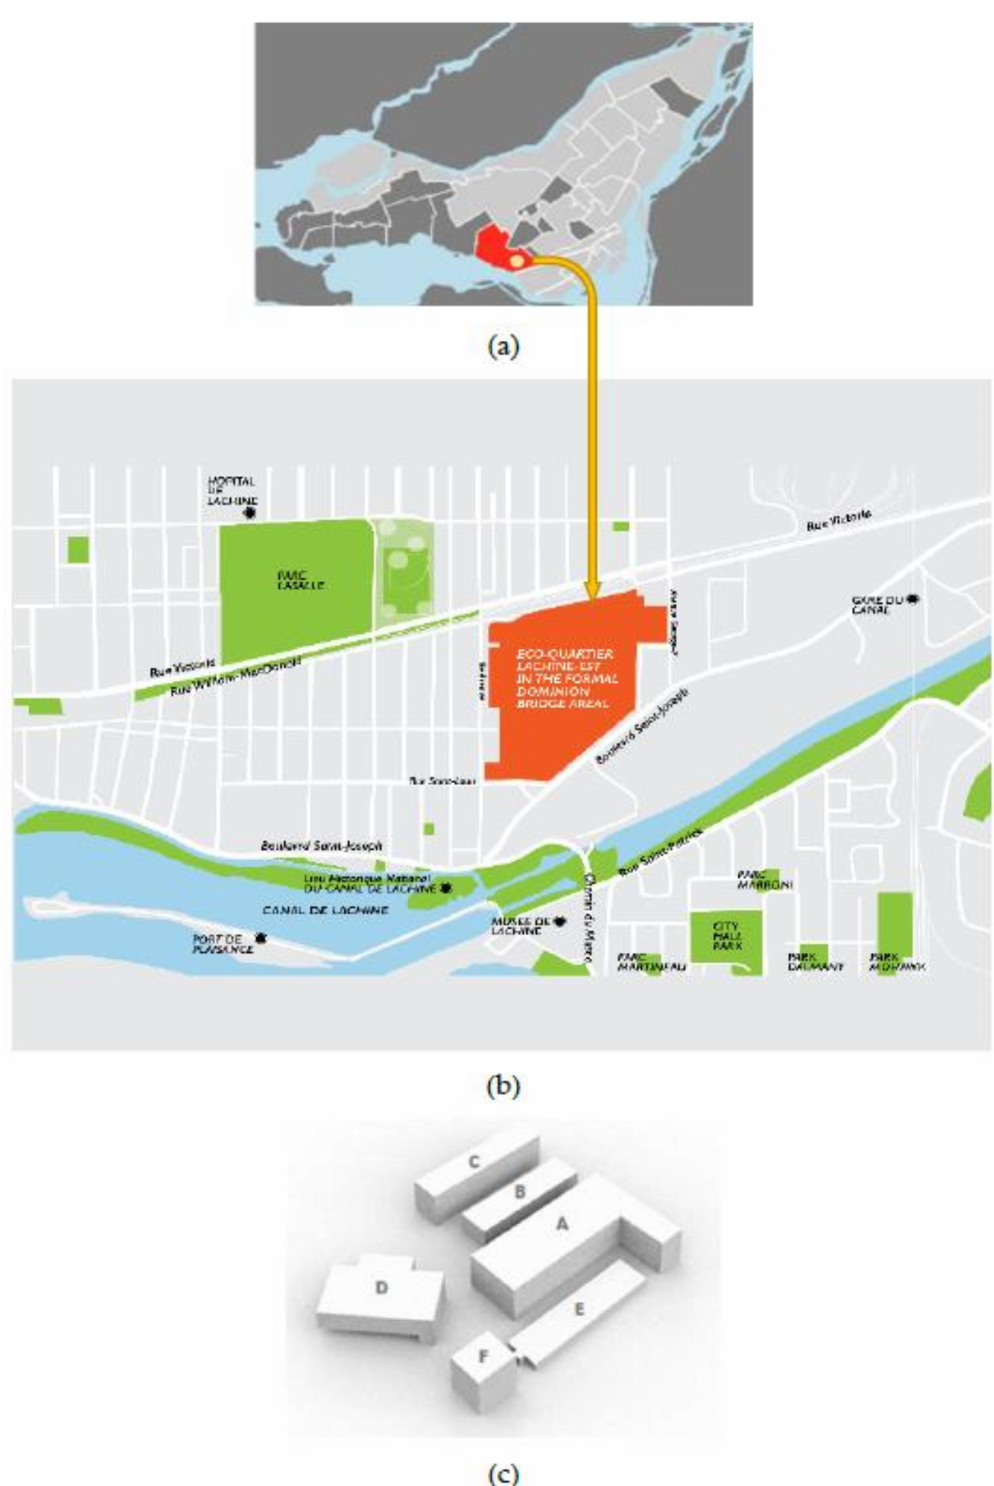
Figure 1. The study area: ( a ) and ( b ) The location of the Lachine-Est quartier in the formal Dominion Bridge Area; ( c ) bird view of buildings distribution in the newly proposed